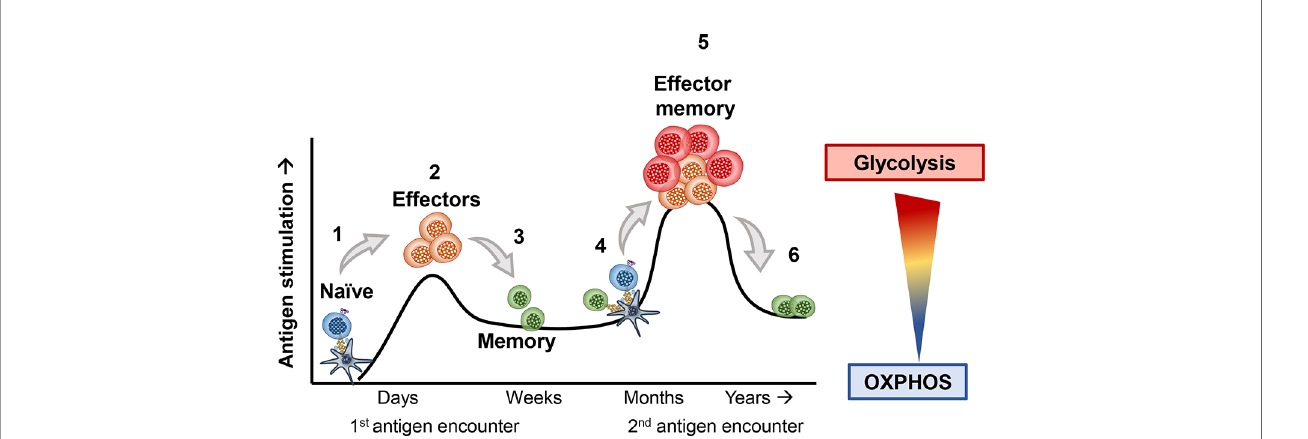
FIGURE 1 | 1) Naive T cells breakdown glucose and ef fi ciently break it down through the tricarboxylic acid (TCA) cycle and oxidative phosphorylation (OXPHOS) to survive, until they encounter their antigen. 2) Upon a primary exposure to antigen, naïve T cells differentiate into effector T cells. As effectors they shift towards the use of amino acids as well as glucose, both required for their proliferation and cytolytic activity. 3) After clearing their inciting antigen, many effector T cells die. However, a fraction of surviving T cells can form memory T cells, which adapt towards improved mitochondrial biogenesis and OXPHOS. 4) These memory T cells can survive for many months to years until they encounter a similar antigen. 5) If these memory T cells re-encounter the same antigen, they rapidly become effectors and more ef fi ciently engage in glycolysis and amino acid usage to robustly proliferate and secrete cytokines. 6) The T cells that survive maintain their usage of OXPHOS to persist long-term within